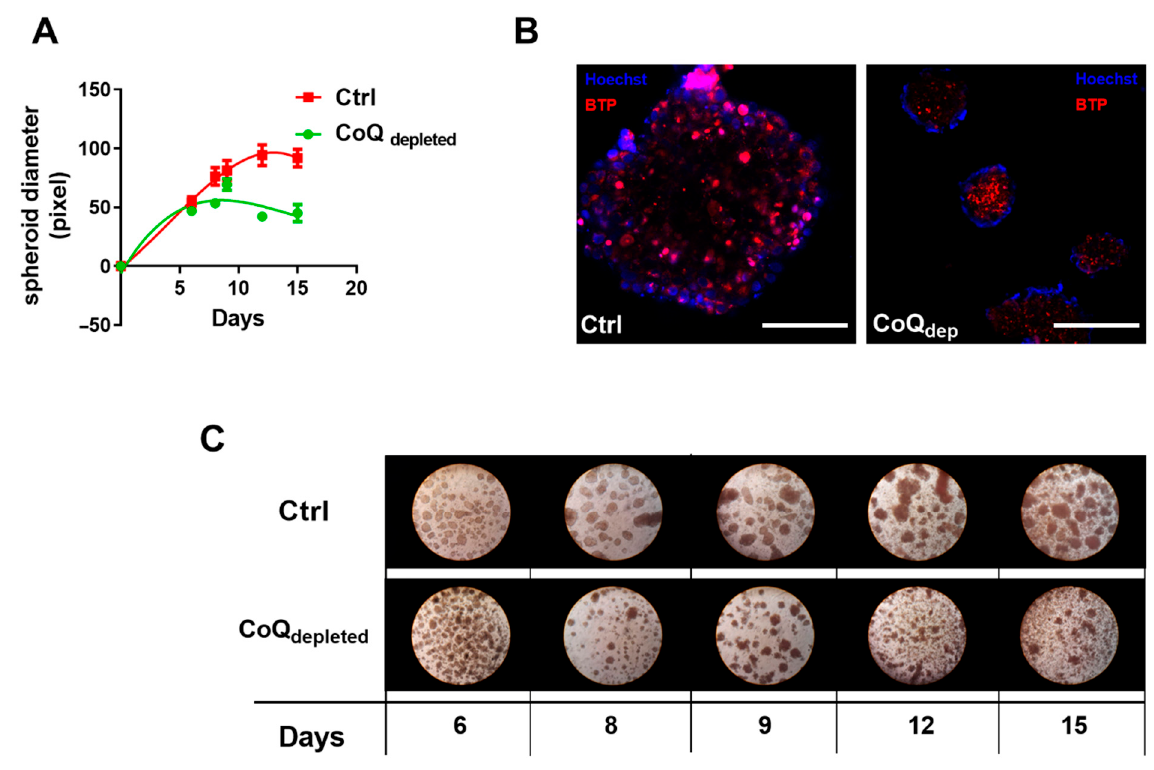
Figure 6. Effect of CoQ depletion on spheroids formation . ( A ) Control and CoQ depleted cells were cultured in complete medium and complete medium supplemented with 4 mM 4-NB respectively in high Bioinert Ibidi dishes to allow spheroids formation. The diameter of the spheroid was monitored for 15 days and measured using ImageJ software. ( B ) Representative micrographs of control and CoQ-depleted spheroids stained with Hoechst and the oxygen sensitive probe BTP. Bar size = 100 µ m. ( C ) Representative phase contrast light micrographs of control and CoQ-depleted spheroids at different time points.